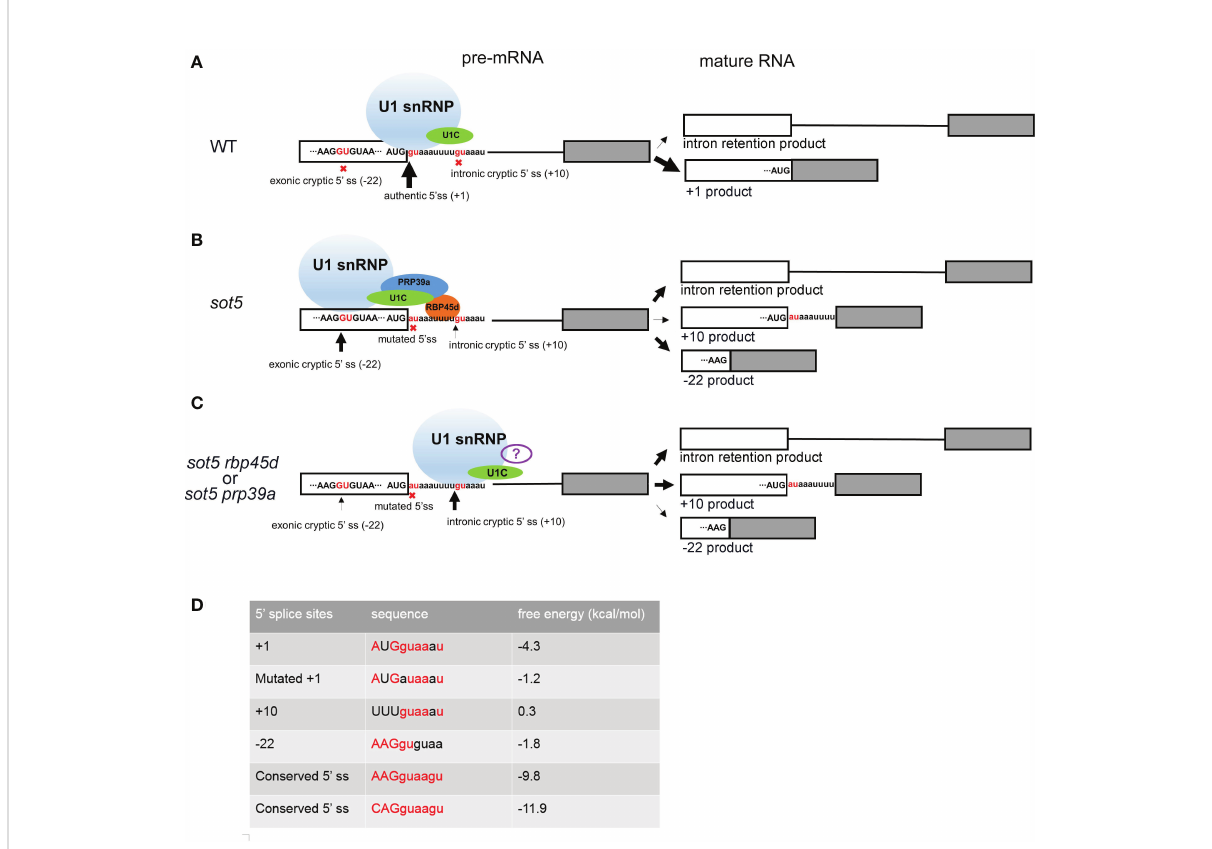
FIGURE 10 Working model of RBP45d and PRP39a in 5 ’ cryptic splice site selection. (A) In WT plant, most SOT5 transcripts are excised intron 7 and only a very small proportion of SOT5 transcripts retained intron 7. Since the authentic 5 ’ ss is strong enough to well base pair with U1 snRNA and recruit U1 snRNP, no cryptic 5 ’ ss nearby were used. (B) In sot5 , the mutation of the authentic 5 ’ ss of SOT5 intron7 led to the reduced base pairing with U1 snRNA, so that the exonic and intronic cryptic 5 ’ ss nearby are activated. Beside, nearly half transcripts retained intron 7. In this scenario, RBP45d binds to the U-rich element located downstream of the exonic cryptic 5 ’ ss and recruits U1 snRNP to select the exonic cryptic 5 ’ ss by physically interacting with both U1C and PRP39a. It is also likely that the RBP45d bound to the U-rich element which is proximal to the intronic cryptic 5 ’ ss masks this 5 ’ ss. (C) When RBP45d or PRP39a is absent or disrupted, the masked intronic cryptic 5 ’ ss is exposed and is preferred by the U1 snRNP complex (lacking PRP39a and RBP45d or with some other unknown splicing factors). The white and gray boxes indicate the exon 7 and exon 8 of SOT5 transcripts, respectively. The black lines indicate the intron 7. The sequence nearby the 5 ’ ss of intron 7 was shown and the invariant GU dinucleotides were colored by red. The nine nucleotides AUGguaaau indicate the authentic 5 ’ ss in WT. The nine nucleotides AUGauaaau indicate the mutated 5 ’ ss in sot5 . The nine nucleotides AAGGUGUAA indicate the exonic cryptic 5 ’ ss in SOT5 exon 7. The nine nucleotides uuuguaaau indicate the intronic cryptic 5 ’ ss in SOT5 intron7. The red crosses indicate the splice sites were not used. The black arrows indicate the usage of the 5 ’ ss and the thickness of the arrows indicate the frequency of the splice site usage. (D) Comparison of the conserved degree of these 5 ’ ss and the free energy of the RNA duplex formed by the 5 ’ ss based pairing with the 5 ’ end of U1 snRNA. The conserved 5 ’ ss sequence well based paired with the 5 ’ end of U1 snRNA, the free energy of the RNA duplex is low. On the contrast, if the 5 ’ ss sequence did not based paired with the 5 ’ end of U1 snRNA, the free energy of the RNA duplex is relatively high. The conserved nucleotides are highlighted by red color. The free energy was calculated by The RNAeval web server